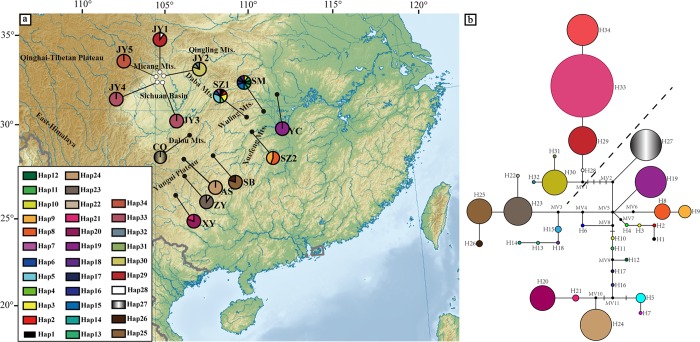
The distributions of nrDNA genotype and Network relationships.(a) Geographical distribution of nrDNA haplotypes (H1–H34) detected in U. rockii and U. henryi (population codes see Table 1). (b) Median-joining network of nrDNA haplotypes (H1–H34). Sizes of the circles in the network are proportional to the observed frequencies of the haplotypes. The small black bars represent mutation steps and the black dots (MV) represent missing haplotypes. The topographic map is from the website https://en.wikipedia.org/wiki/File:East_Asia_topographic_map.png.